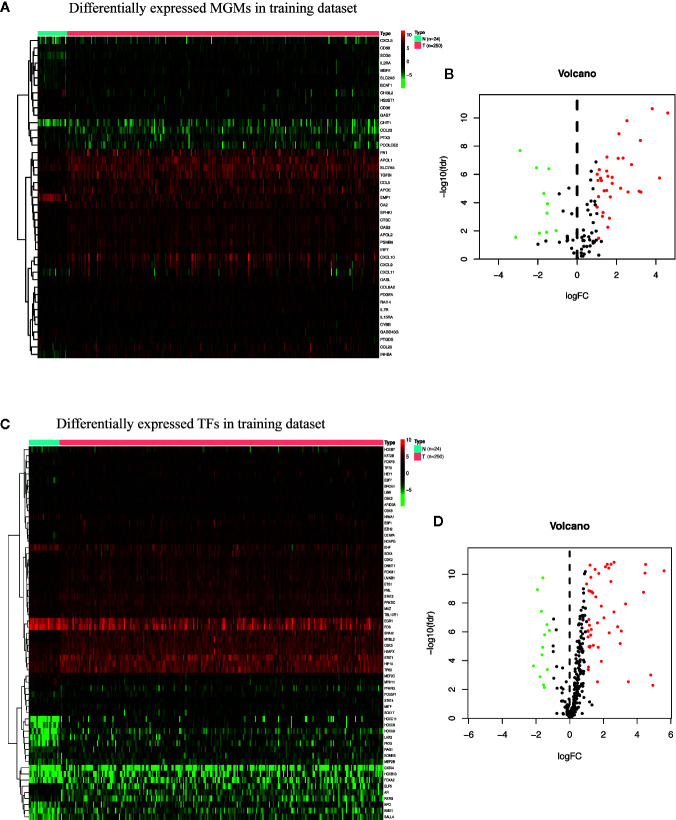
Identification of differentially expressed MGMs and TFs in the training dataset. (A, B) Heat map and volcanic map of 43 differentially expressed MGMs in the training dataset. (C, D) Heatmap and volcanic map of 61 differentially expressed TFs in the training dataset.